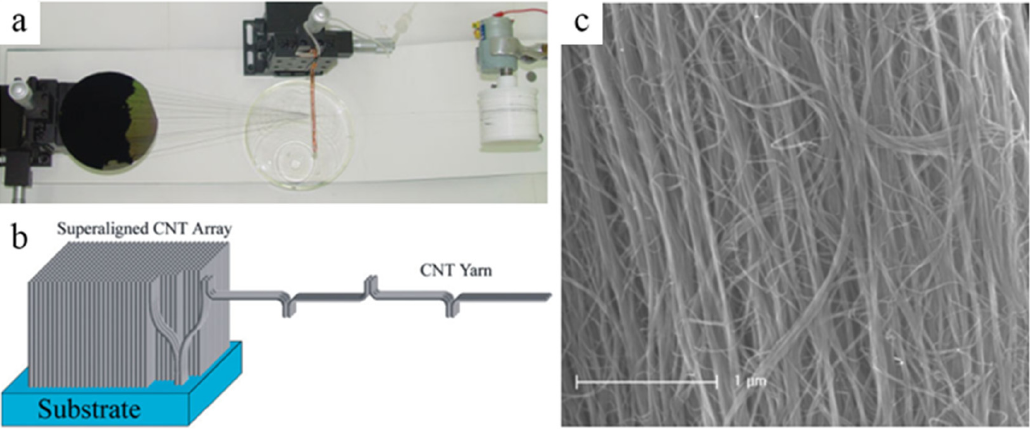
Figure 10. Spinning continuous yarns from super-aligned CNT arrays. ( a ) Top view of spinning apparatus. ( b ) Schematic of the continuous yarn. ( c ) SEM image of yarns after spinning. Reproduced with permission [80]. Copyright 2006, John Wiley and Sons.